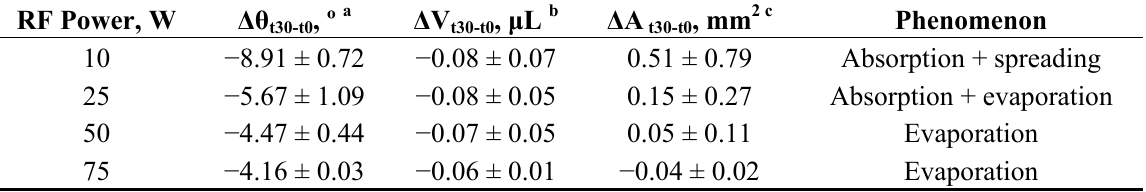
Table 5. Main parameters derived from static water CA measurement of pp–GT thin films.